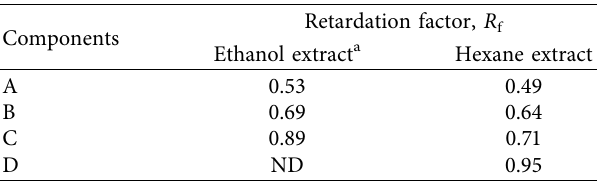
Table 6: Constituents of O. basilicum extracts as determined using